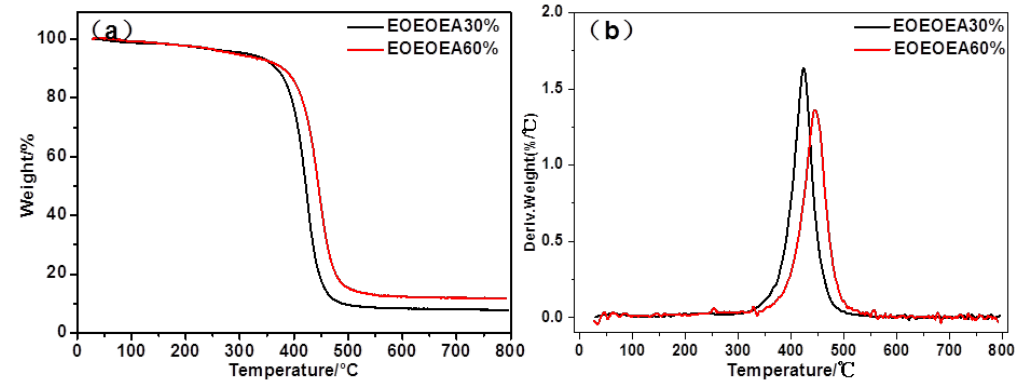
Figure 7. ( a ) TG and ( b ) DTG curves of different gel electrolytes.